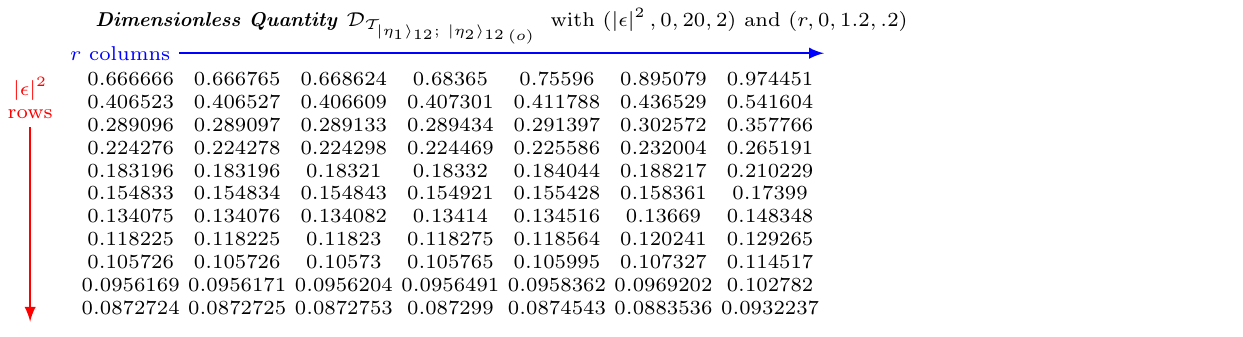
0 . 666666 0 . 666765 0 . 668624